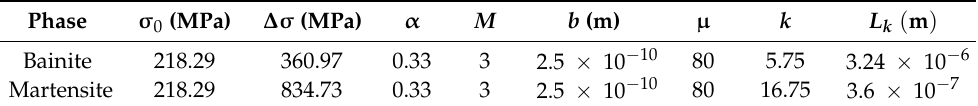
Figure 5. Flow curves for pure martensite and pure bainite specimens were simulated and compared with experimental data (solid lines represent experimental values and dash lines represent fitting values in constitutive model). Table 4. Material parameters to predict the phase flow curves of pure bainite and martensite speci- mens, respectively.